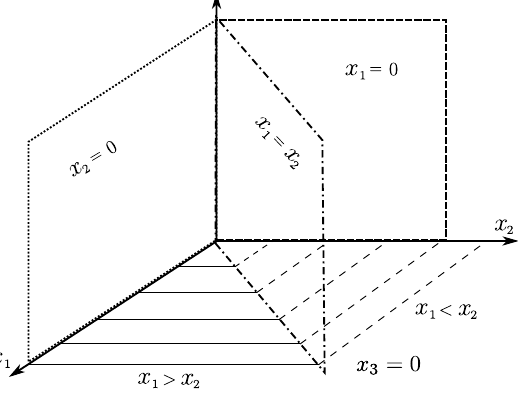
Figure 2. Geometrical representation R 1 , R 2 and R 3